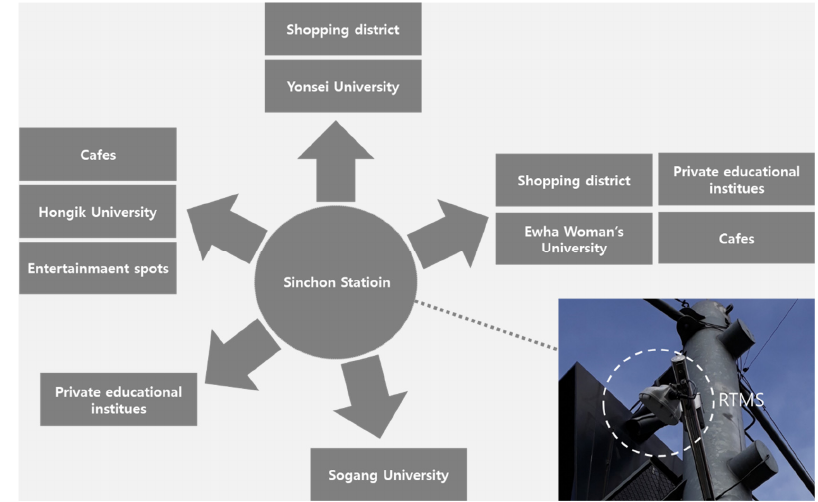
Figure 1. A simplied illustration of 5-way Sinchon Intersection (research site).